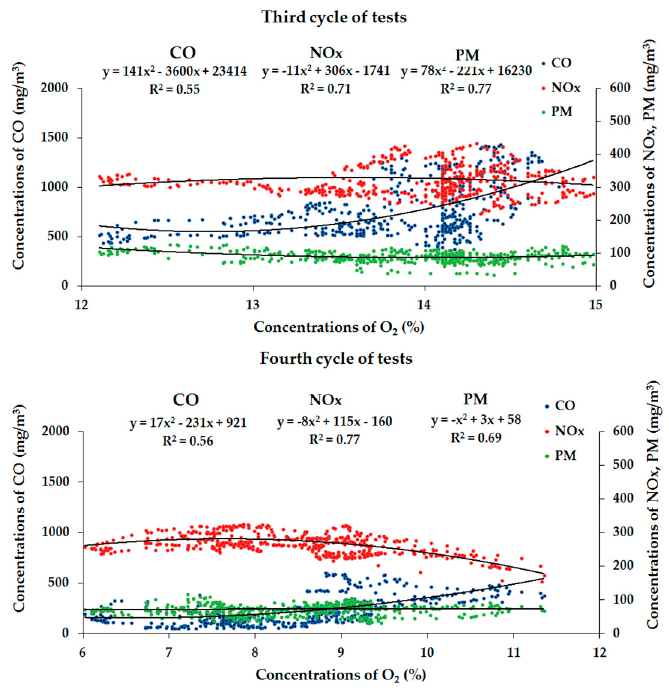
Figure 6. Mass distribution of harmful substances to the remaining amount of oxygen for the third and fourth cycle of tests.